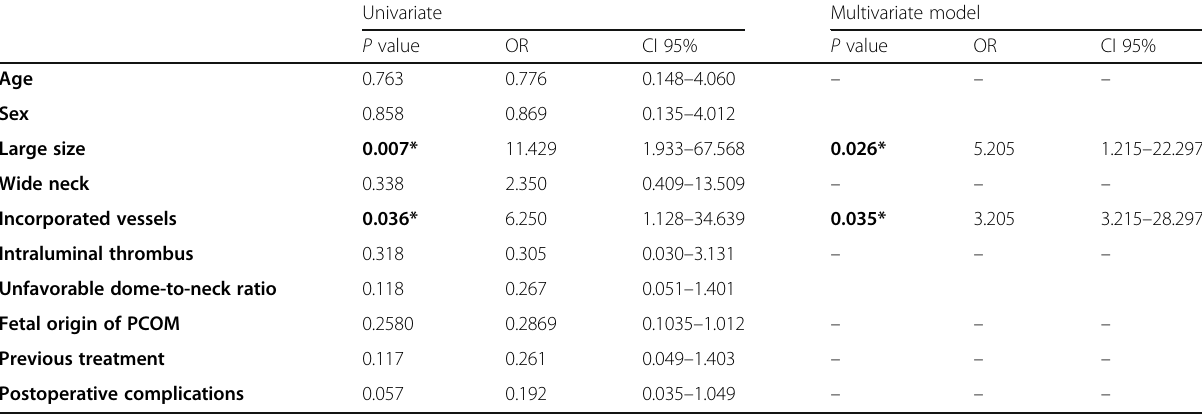
Table 5 Univariate and multivariate logistic regression of predictors of angiographic outcomes Univariate Multivariate